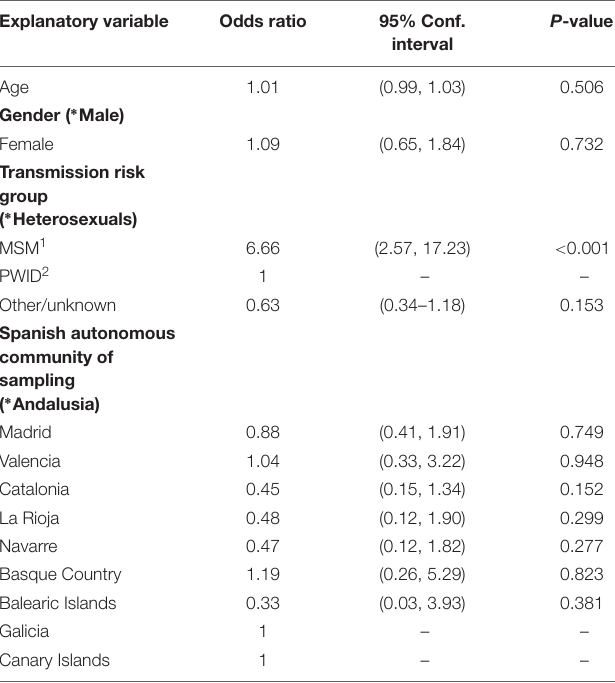
TABLE 2 | Multivariate logistic regression estimates using the presence in monophyletic groups as the binary outcome variable.